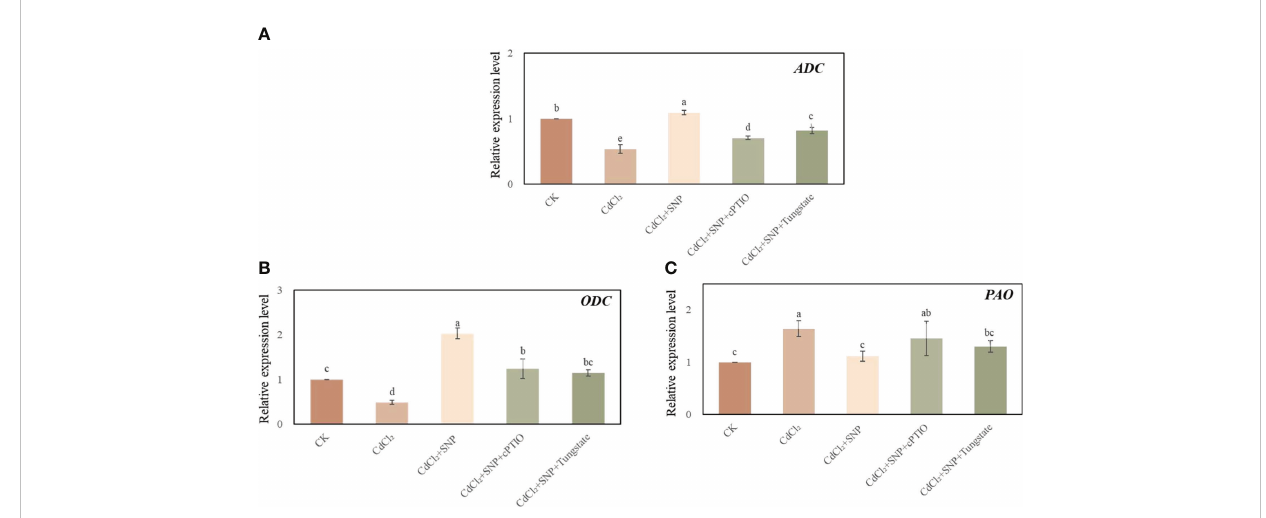
FIGURE 7 Effect of NO on the expression level of ADC ( A ), ODC (B) and PAO ( C ) in cucumber explants under Cd stress at 48 (h) Explants were incubated for 2 days with distilled water (CK) or 1 m M CdCl 2 , 1 m M CdCl 2 +10 m M SNP, 1 m M CdCl 2 + 10 m M SNP + 200 m M cPTIO, 1 m M CdCl 2 + 10 m M SNP + 200 m M Tungstate. The values (means ± SE) are the average of three independent experiments. Bars with different letters are signi fi cantly different at P < 0.05 according to Duncan ’ s multiple range